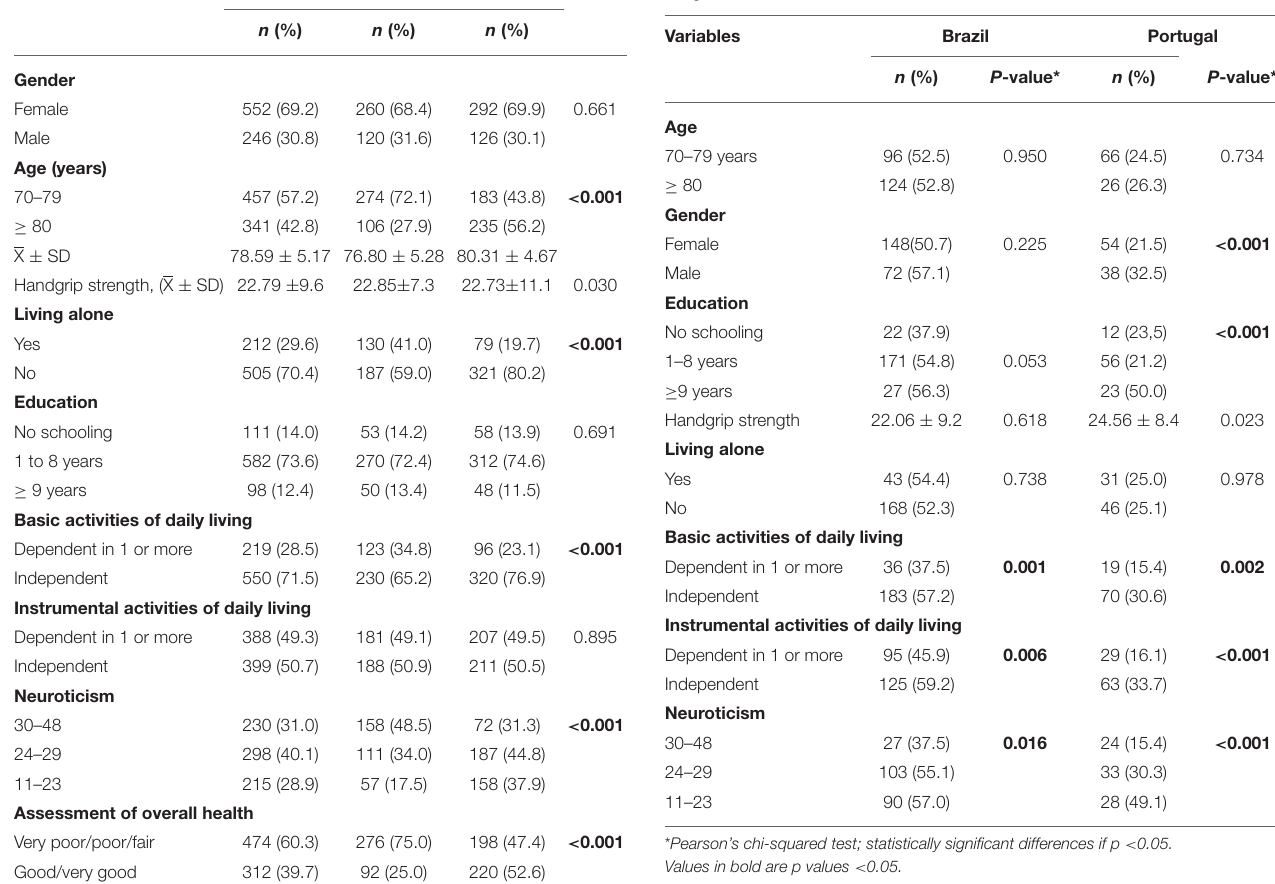
self-rated health as “good” or “very good,” considering sociodemographic variables, independent performance of basic and instrumental activities of daily living and